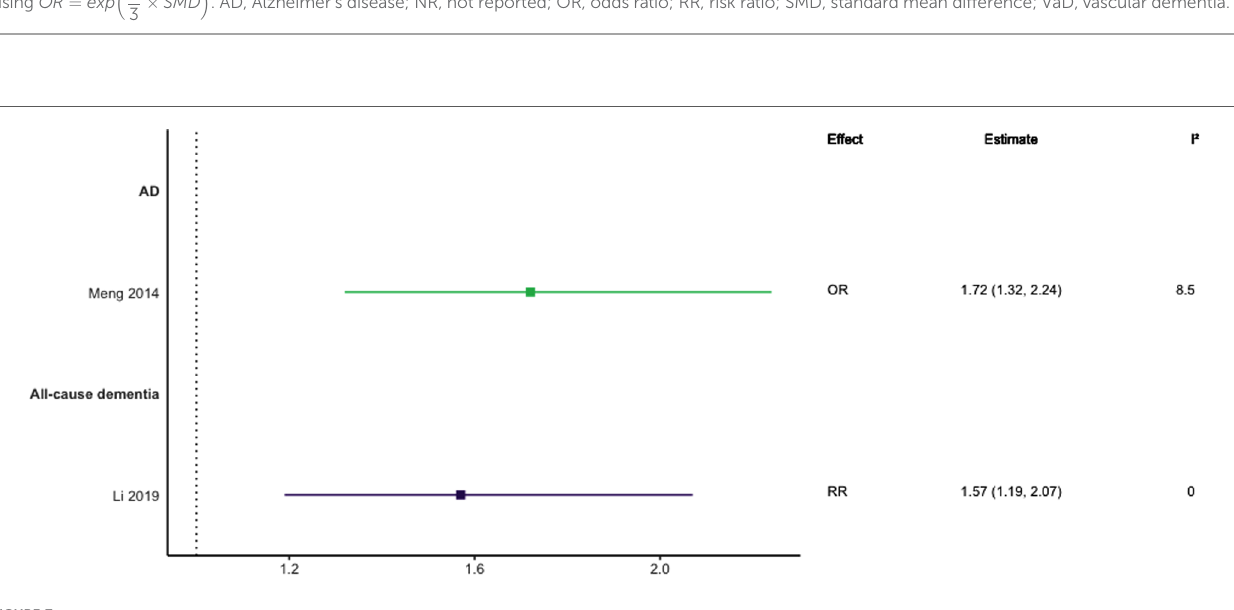
FIGURE 7 Effect estimates of meta-analyses reporting an association between hypercholesterolaemia and dementia, with the vertical line representing no effect. AD, Alzheimer ’ s disease; OR, odds ratio; RR, risk